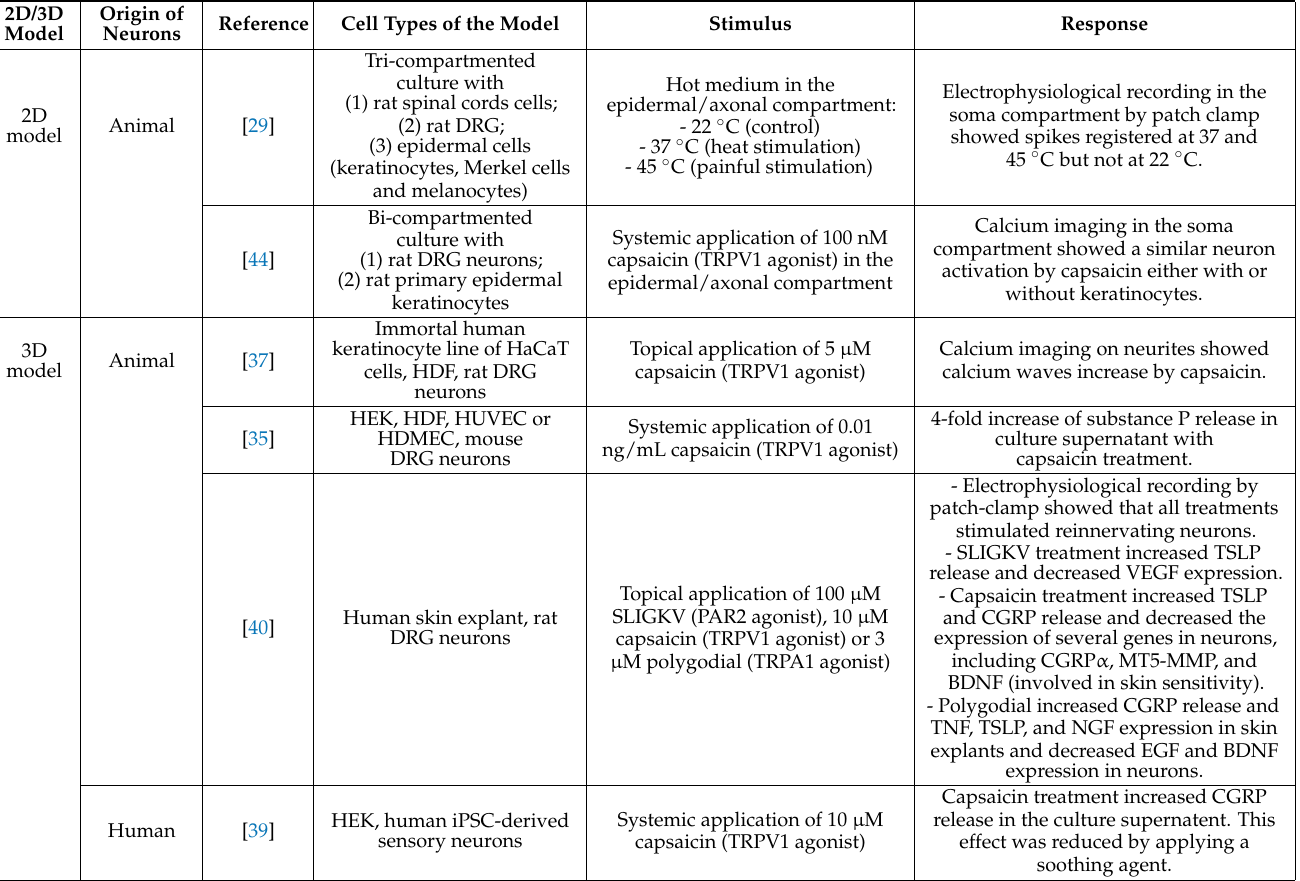
Table 1. In vitro models containing at least sensory neurons and keratinocytes in which the response to thermal or chemical stimulus has been tested. DGR: dorsal root ganglia; HDF: human dermal fibroblasts; HDMEC: human dermal microvascular endothelial cells; HEK: human primary epidermal keratinocytes; HUVEC: human umbilical vein endothelial cells; TRPV1: transient receptor potential vanilloid